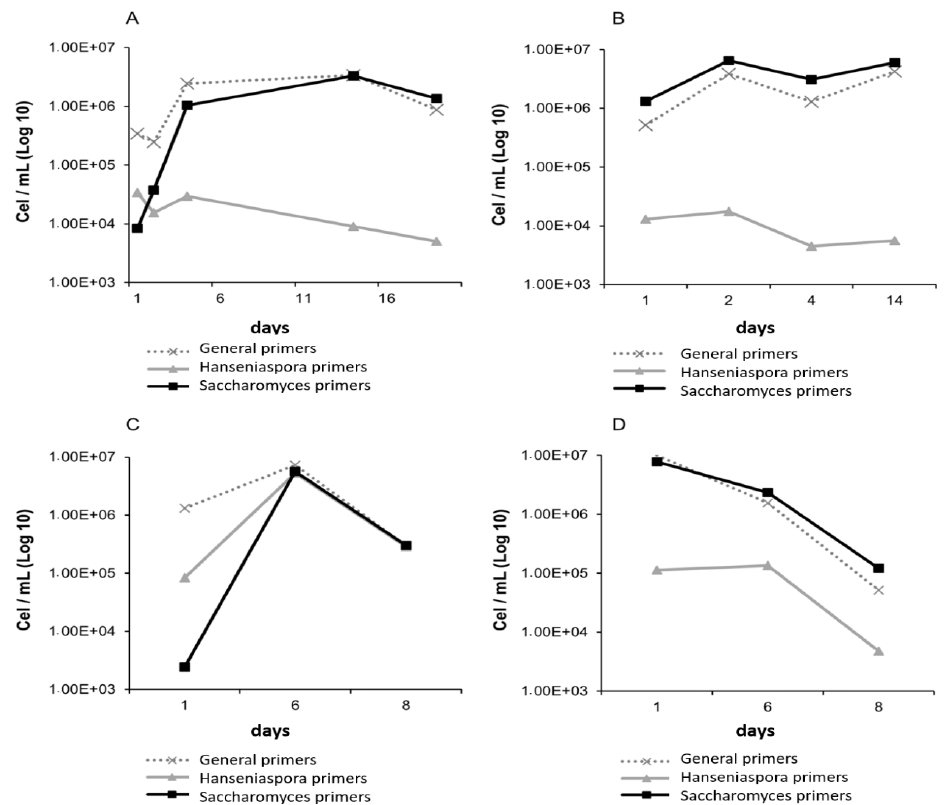
Figure 10. Monitoring of the yeast population by quantitative polymerase chain reaction, with general primers for yeasts (punctate), specific for Hanseniaspora spp. (grey) and specific for Saccharomyces (black), in Macabeo ( A , B ) and Merlot fermentations ( C , D ), in tanks inoculated with H. vineae ( A , C ) and tanks inoculated with S. cerevisiae ( B , D ).